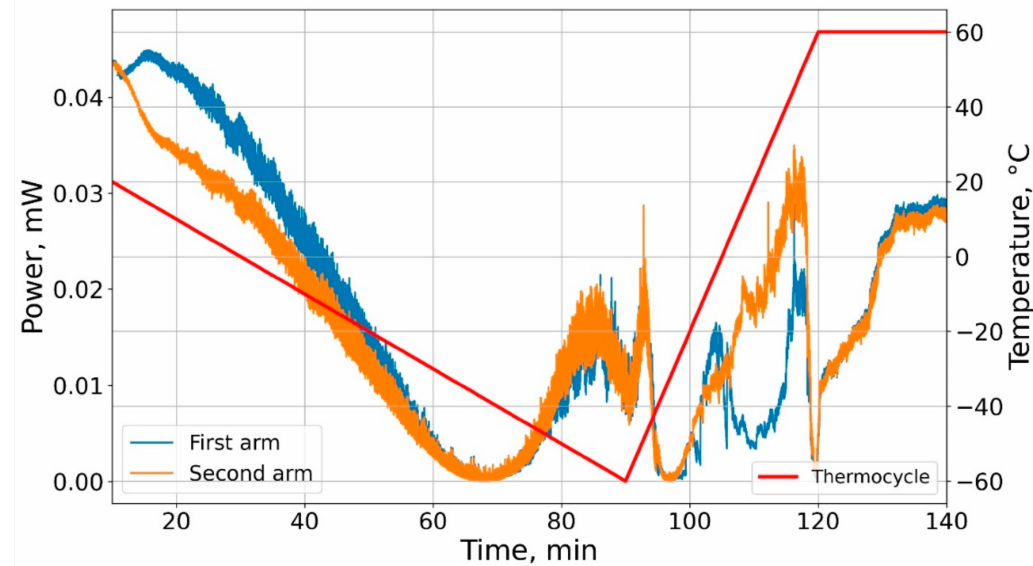
Figure 3. Dependence of the output power in the two channels (orange and blue curves) of the IOM and the sample temperature on time.